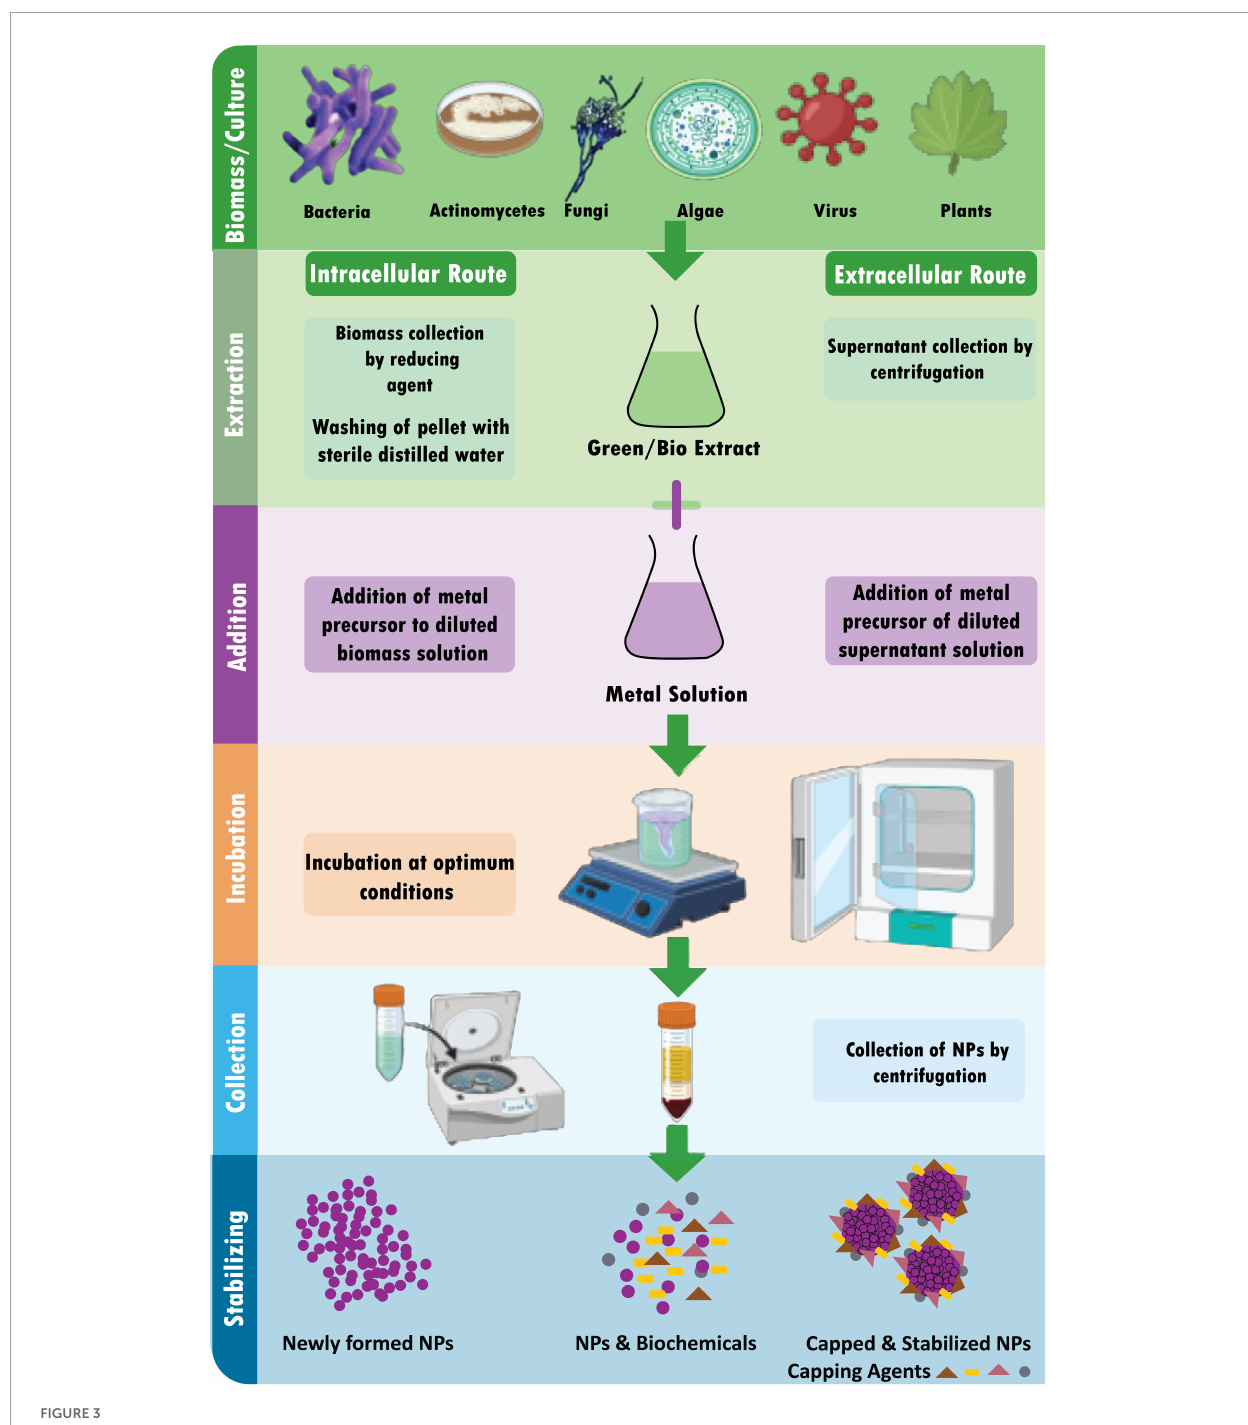
FIGURE3 Schematic diagram for biosynthesis of NPs.